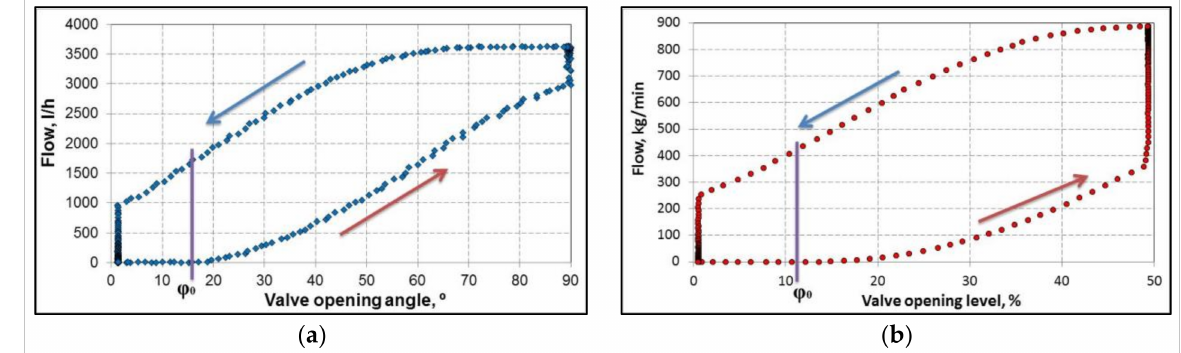
Figure 6. Test characteristics for the procedure (O/Z) with indication of the dead angle for: ( a ) CBV valve; ( b ) valve from the industrial